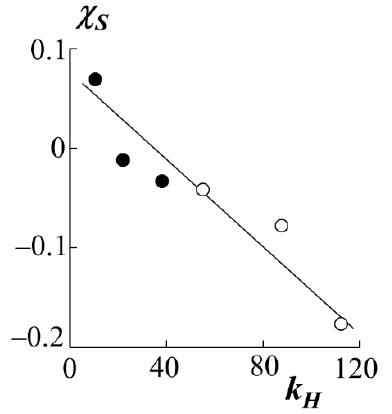
Figure 8. Ratio of entropic χ S and enthalpy k H components of the Flory–Huggins parameter for systems with PS-1 (white dots) and PS-2 (black dots).